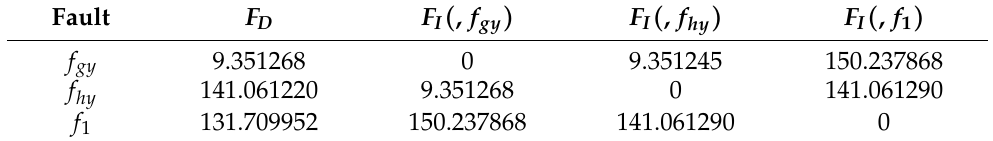
Table 1. Diagnosability indexes on the fault information manifold for the three types of faults.